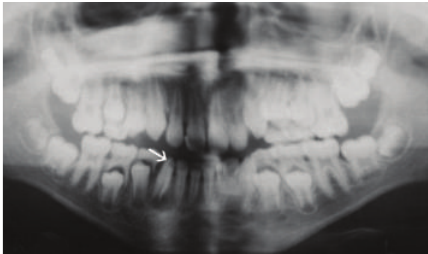
Figure 2: Orthopantomogram taken at initial presentation showing periapical changes in the